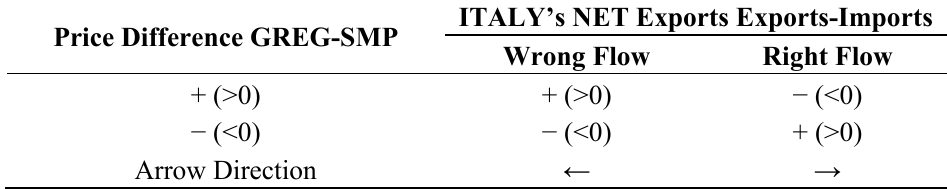
Figure 15. Wavelet coherence of hourly price difference (GREC DA (Day Ahead)–SMP DA) and Exports-Imports difference, for the period 2011. The horizontal axis shows time in Quarters Q 1 to Q 4 , while the vertical axis shows the scale or period in hours. The warmer the colour of a region, the higher the degree of dependence or coherence between the two series. Table 4. Clarification of Variable direction in relation with adverse and right